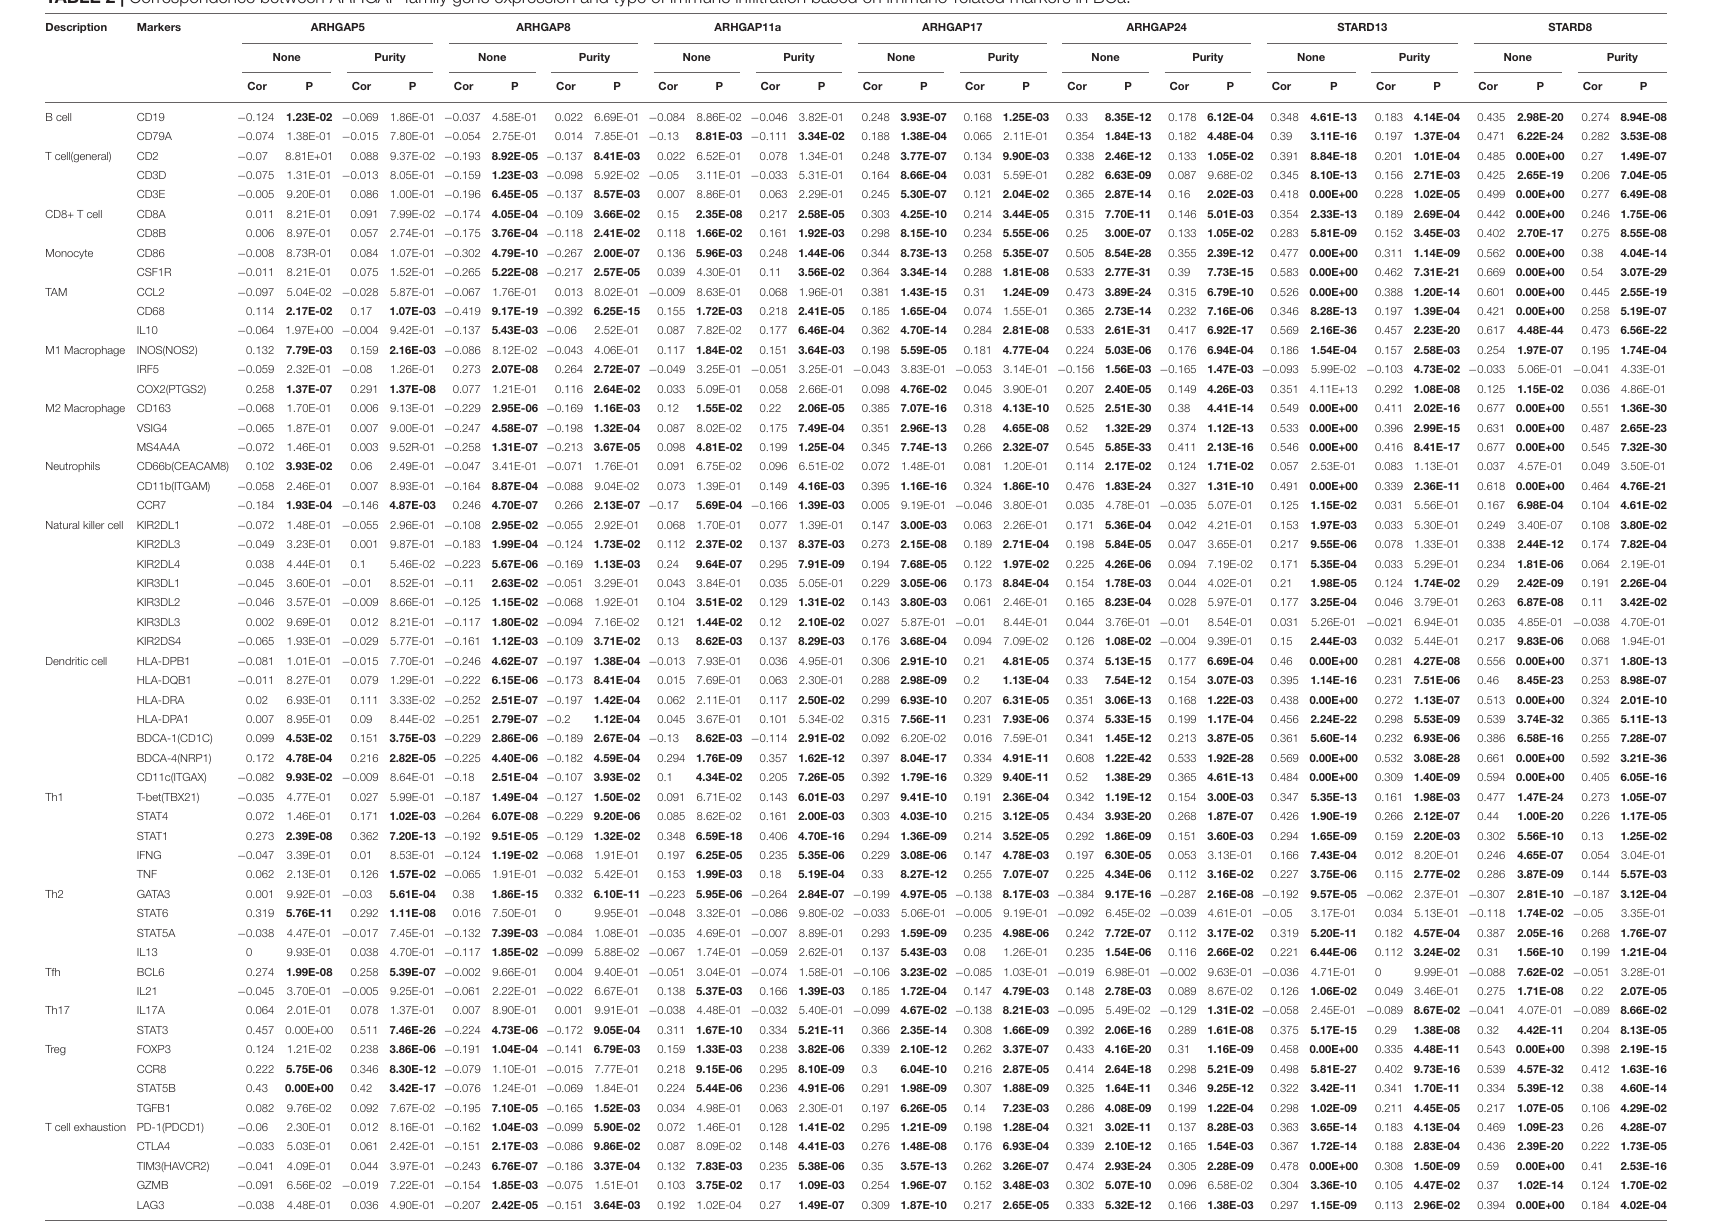
TABLE 2 | Correspondence between ARHGAP family gene expression and type of immune infiltration based on immuno-related markers in BCa.